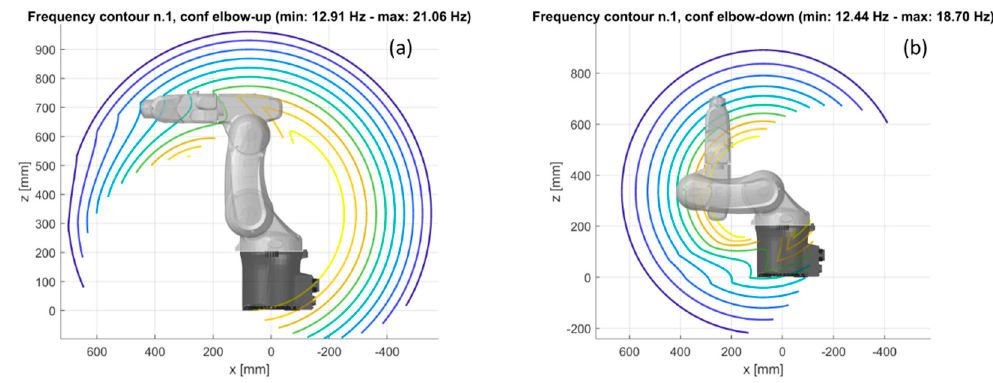
Figure 14. Contour plot of the natural frequency of mode 1 in the meridian plane, ( a ) elbow-up, ( b ) elbow-down.